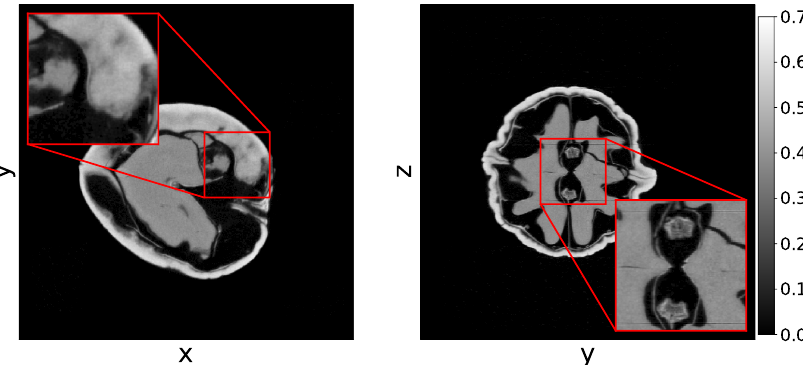
Figure 3. The z = 0 ( Left ) and y = 0 ( Right ) slice of the gold standard reconstruction of the high-dose dataset of the 21st walnut with full number of projection angles. The projection data are acquired using the FleX-ray scanner located at the CWI [55]. The horizontal line artifacts visible in the right figure are due to imperfections in the projection data and not due to the reconstruction